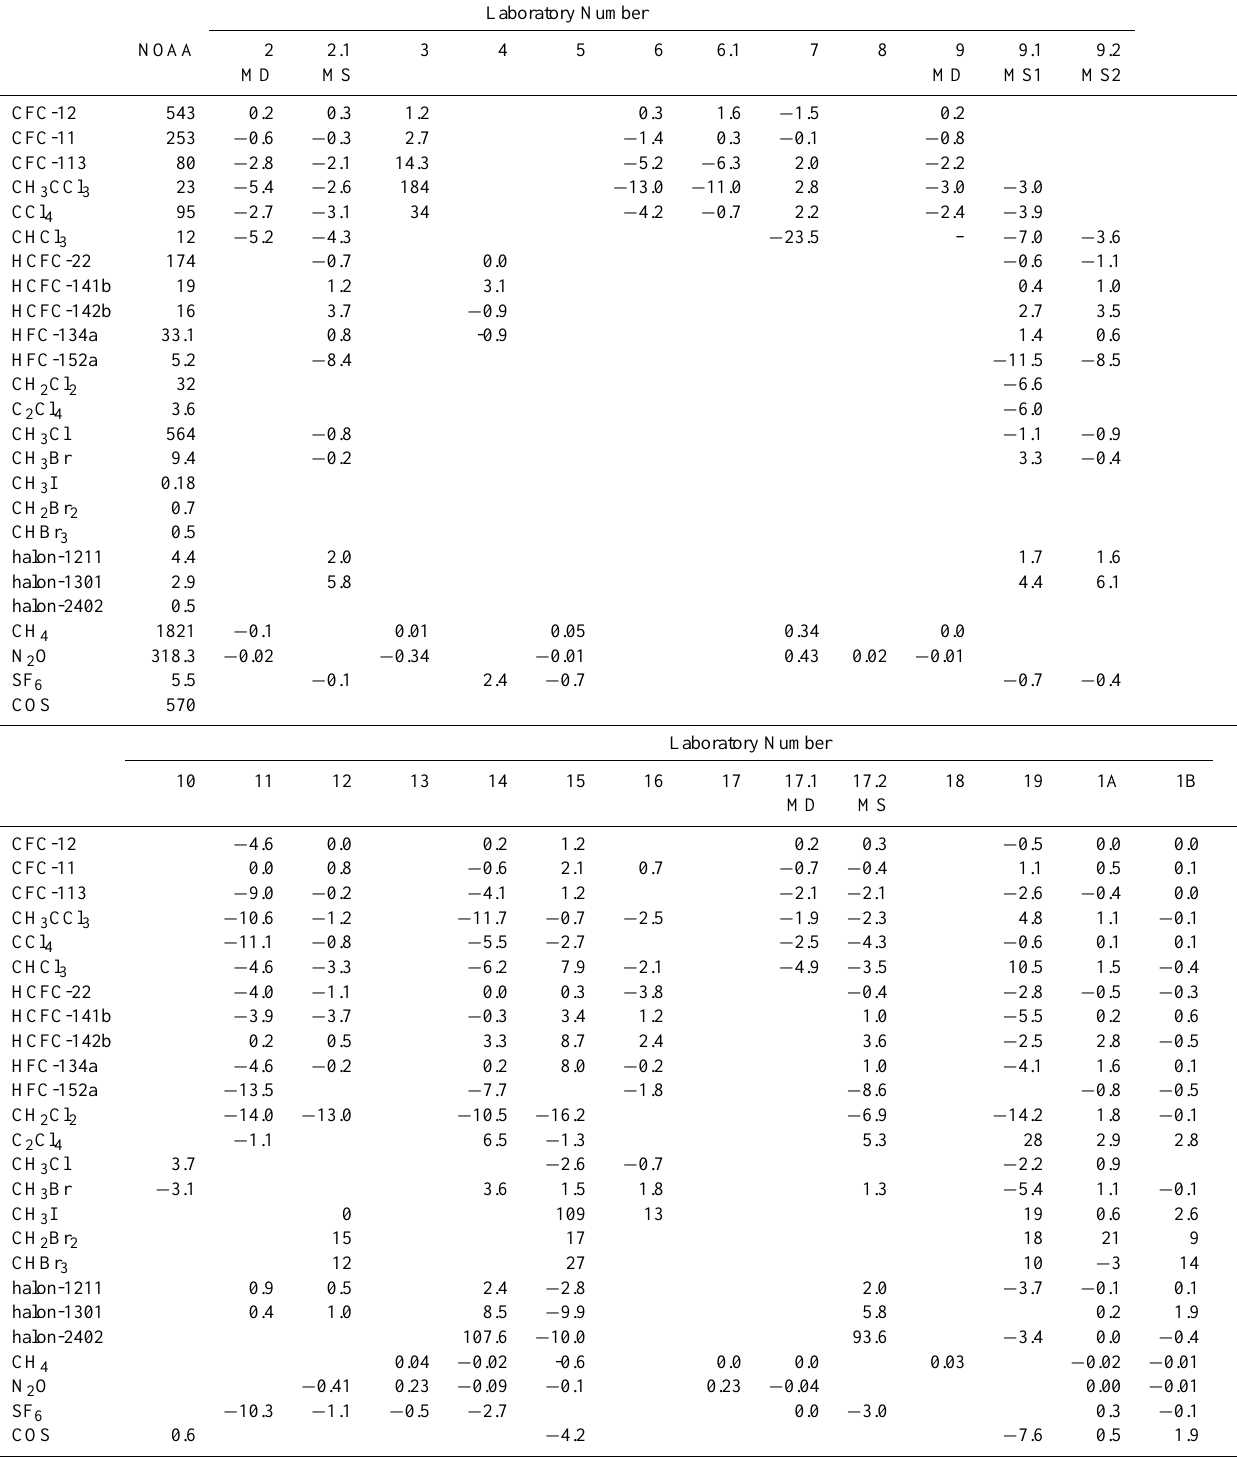
Table 3. Average differences (%) between each laboratory and laboratory 1 (NOAA) for selected compounds (average of both undiluted samples). Each result is compared to the initial NOAA result, except for CFC-12 (final) and CH 2 Br 2 (average of initial and